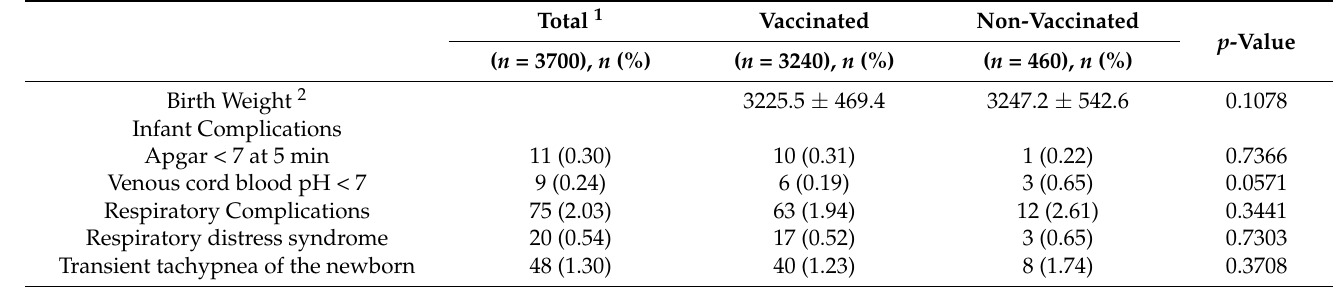
Table 3. Neonatal